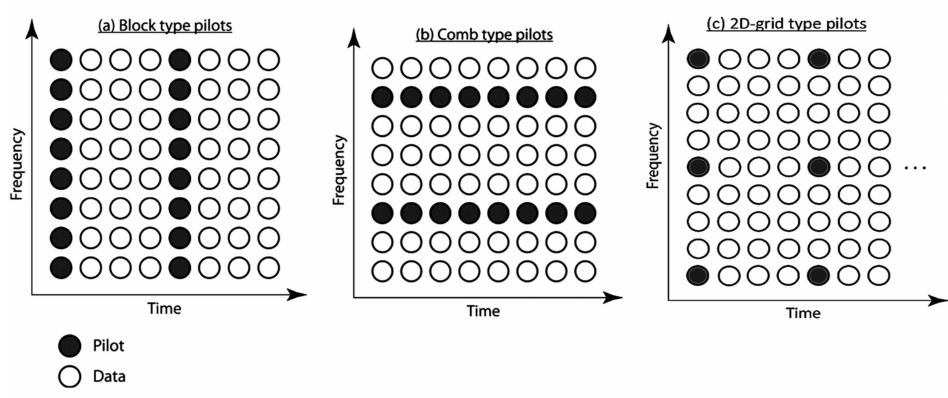
Figure 17. Pilot arrangement possible situations: ( a ) block type; ( b ) comb type; ( c ) 2D-grid type. The shaded circles represent pilot symbols, whereas the unshaded ones represent the symbols to be transmitted. The horizontal axis is the time direction, and the vertical one is the frequency direction that represents the OFDM subcarriers.